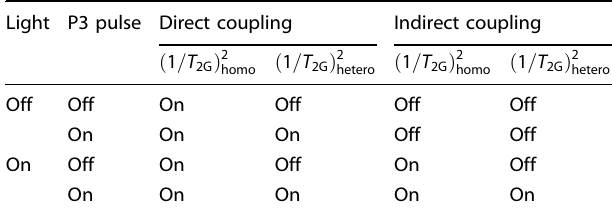
Table 1. Effects of the light illumination and the application of